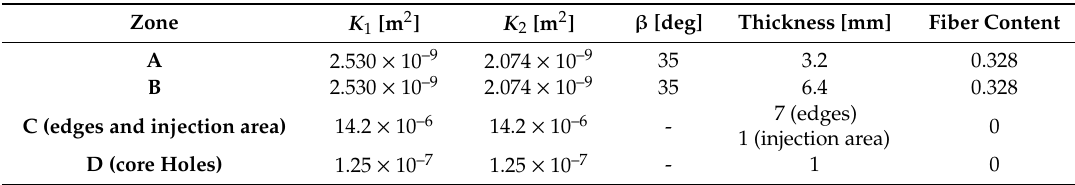
Table 2. Material data of the fiberglass component